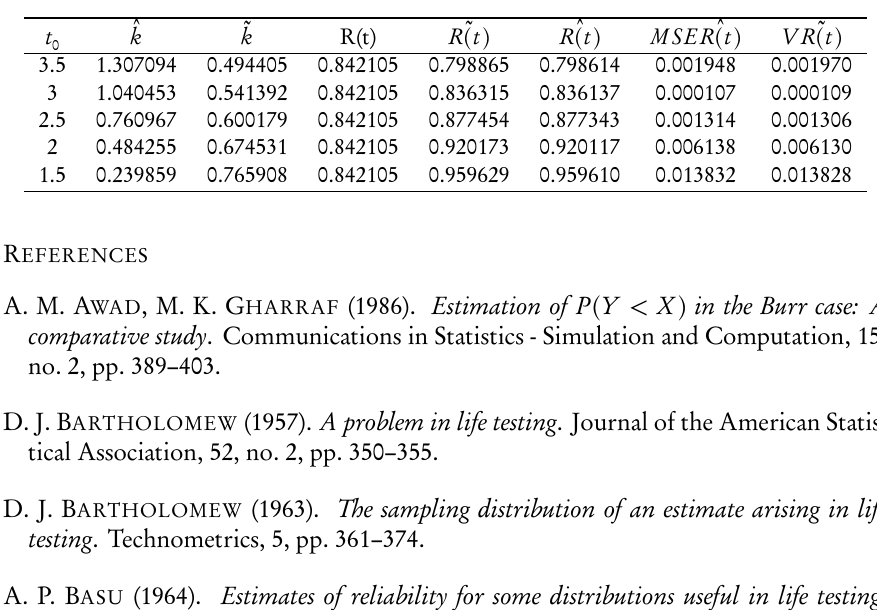
Estimates of k and R(t) for different censoring times, their corresponding variances and